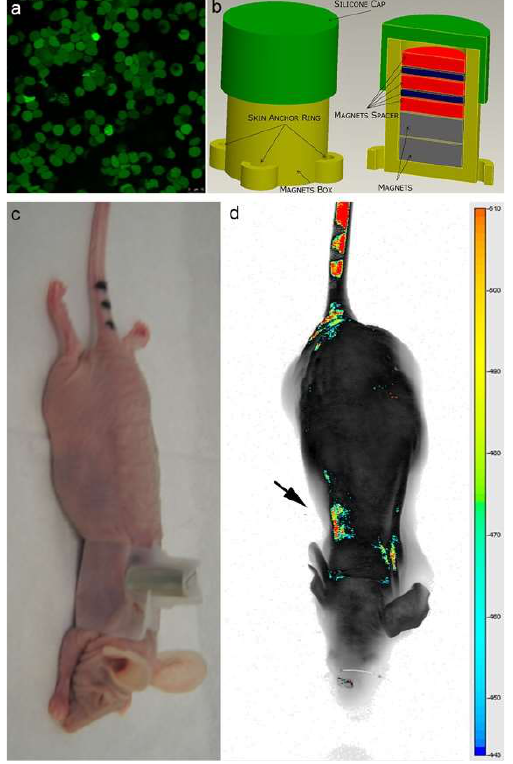
Figure 3. ( a ) Confocal laser scanning microscopy imaging of Erythro–Magneto–HA–Virosomes (EMHVs) incorporating the IRDye800CW-labeled magnetic nanoparticles; ( b ) Schematic representation of silicon backpack containing removable magnet; ( c ) Athymic Balb/c Nude mice with the silicon backpack containing the removable magnet on its right back; ( d ) The longitudinal NIR in vivo imaging (LICOR-Bioscience): dorsal view of IRDye 800CW-labeled EMHVs pseudocolor fluorescence distribution in the whole body. The black arrow indicates the position of the magnet.